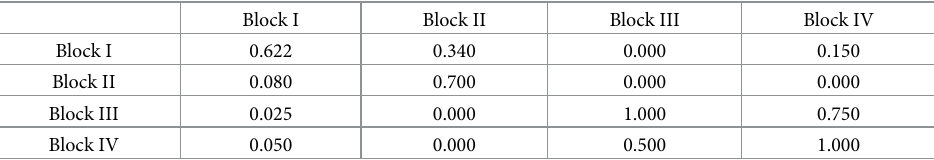
Table 13. Density matrix of blocks.